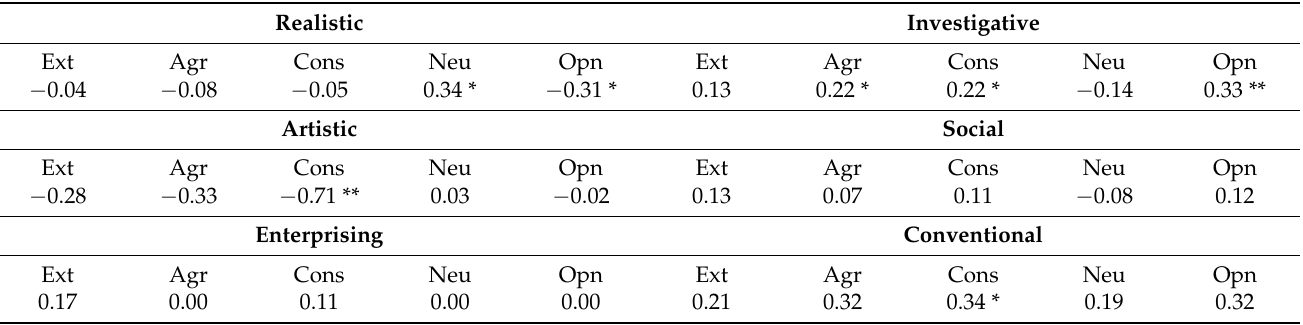
Table 3. Spearman’s correlation between Congruence and Personality in RIASEC types.